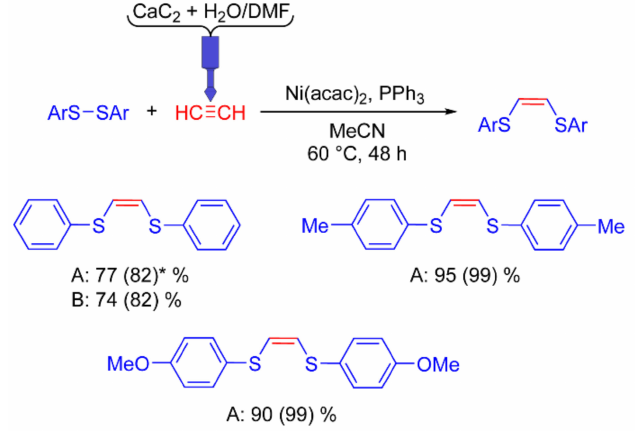
Figure 8. Scope of the reaction of 1,2-bis(arylthio)ethene synthesis using the designed reactor (A) and acetylene from a gas cylinder (B). * NMR yields in